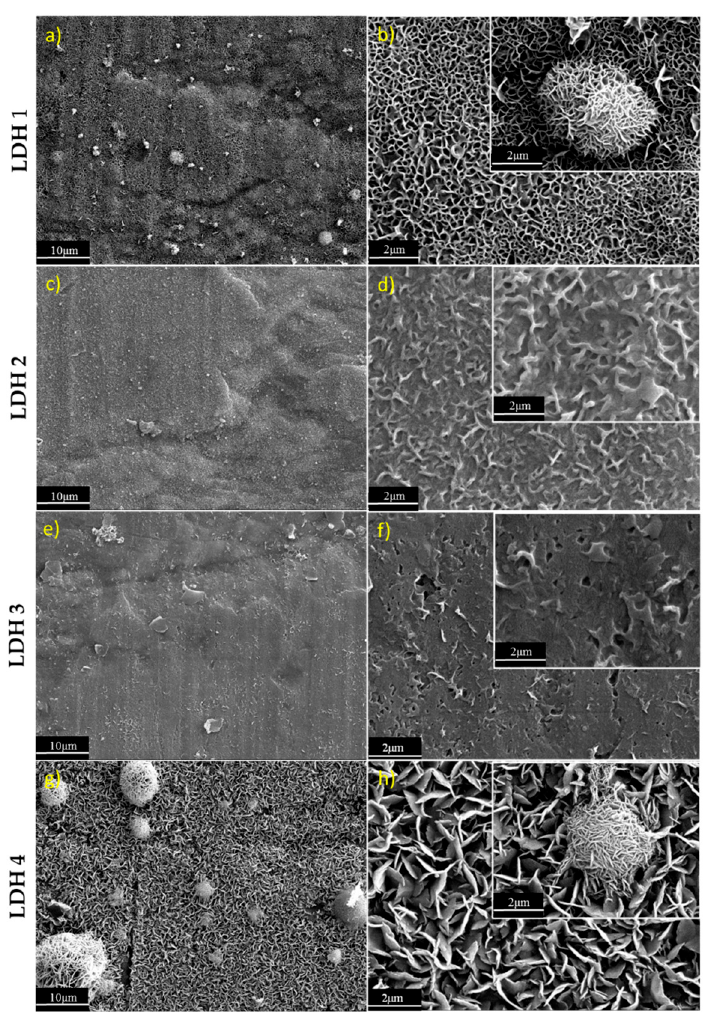
Figure 5. Secondary electron images of the LDH 1 ( a , b ) LDH 2 ( c , d ), LDH 3 ( e , f ) and LDH 4 ( g , h ) coatings.